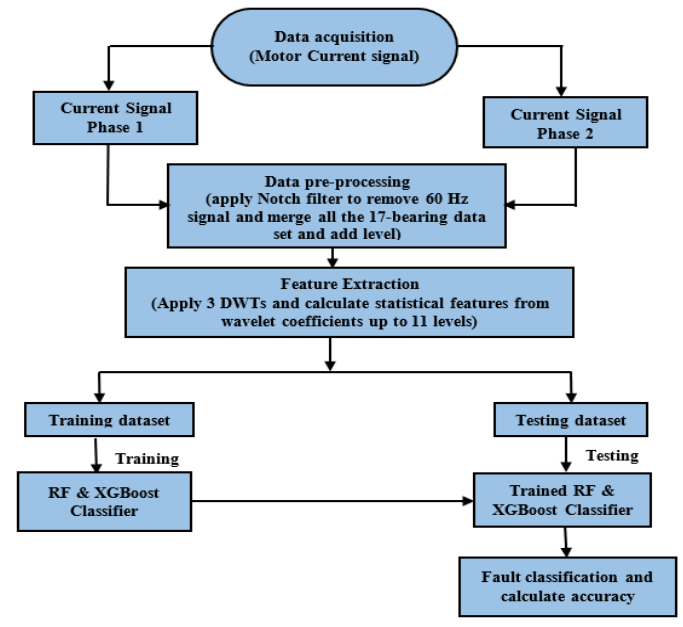
Figure 4. Workflow of the proposed method for bearing fault classification of IM.